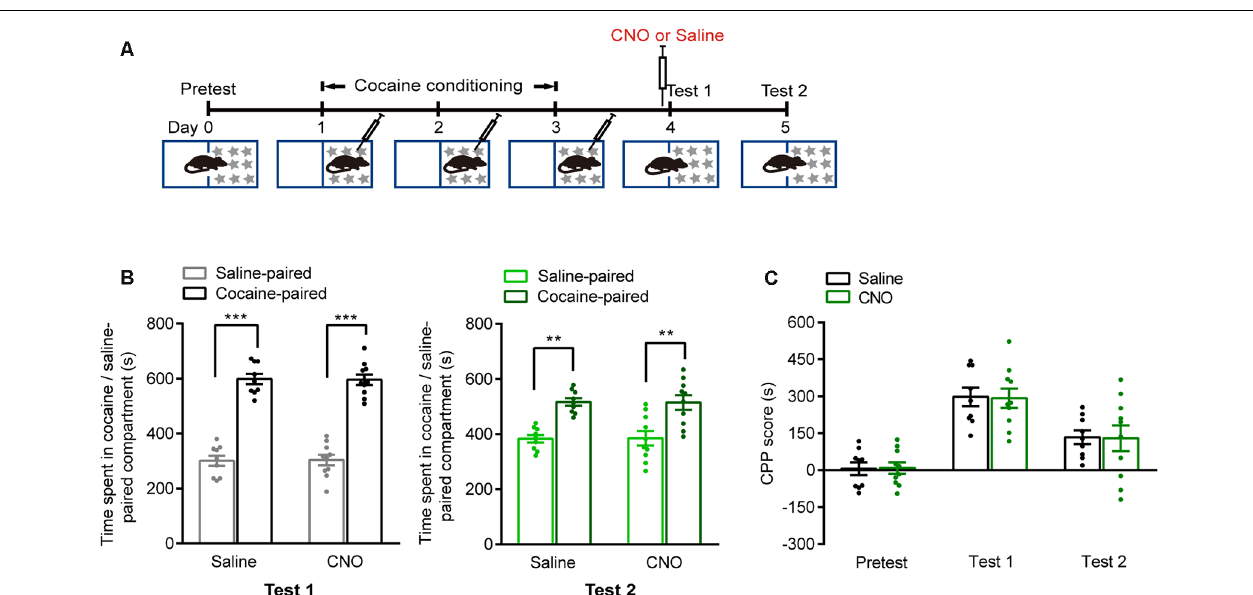
FIGURE 4 | CNO treatment did not suppress the retrieval of cocaine-CPP memory. (A) Behavioral schedule. Saline or CNO (1 mg/kg, i.p.) was injected 30 min before test 1. (B) Bar graphs representing the time spent in the cocaine-paired and the saline-paired compartments of saline- and CNO-treated groups in test 1 and test 2 sessions. ** P < 0.01, *** P < 0.001 vs. saline-paired compartment. (C) Bar graph showing the CPP scores of saline- and CNO-treated groups (Saline n = 9, CNO n = 10).